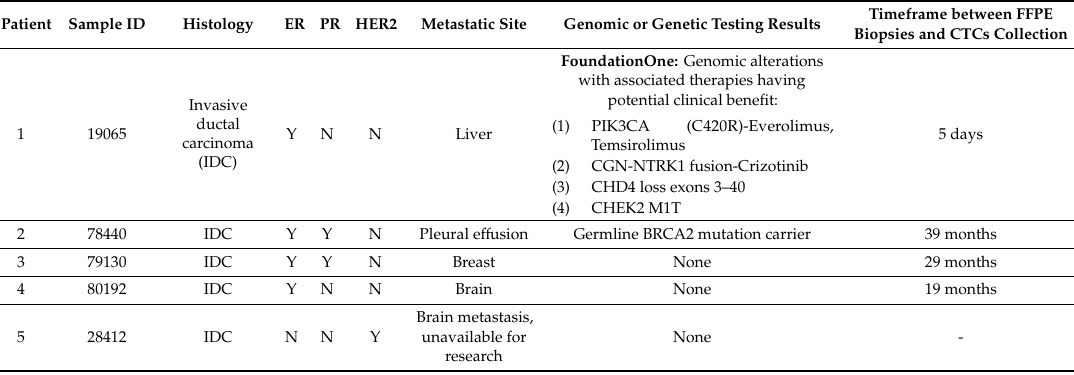
Table 4. Clinicopathological information of breast cancer